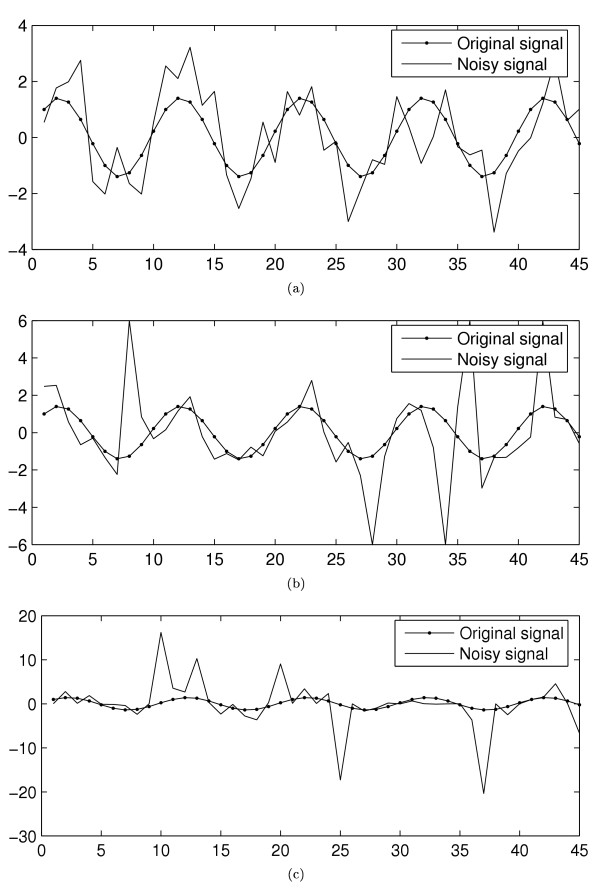
Examples of time series. An example of a time series composed of a sine and (a) additive standard Gaussian noise, (b) additive standard Gaussian and impulsive noise, and (c) additive standard Gaussian noise and cubic distortion.